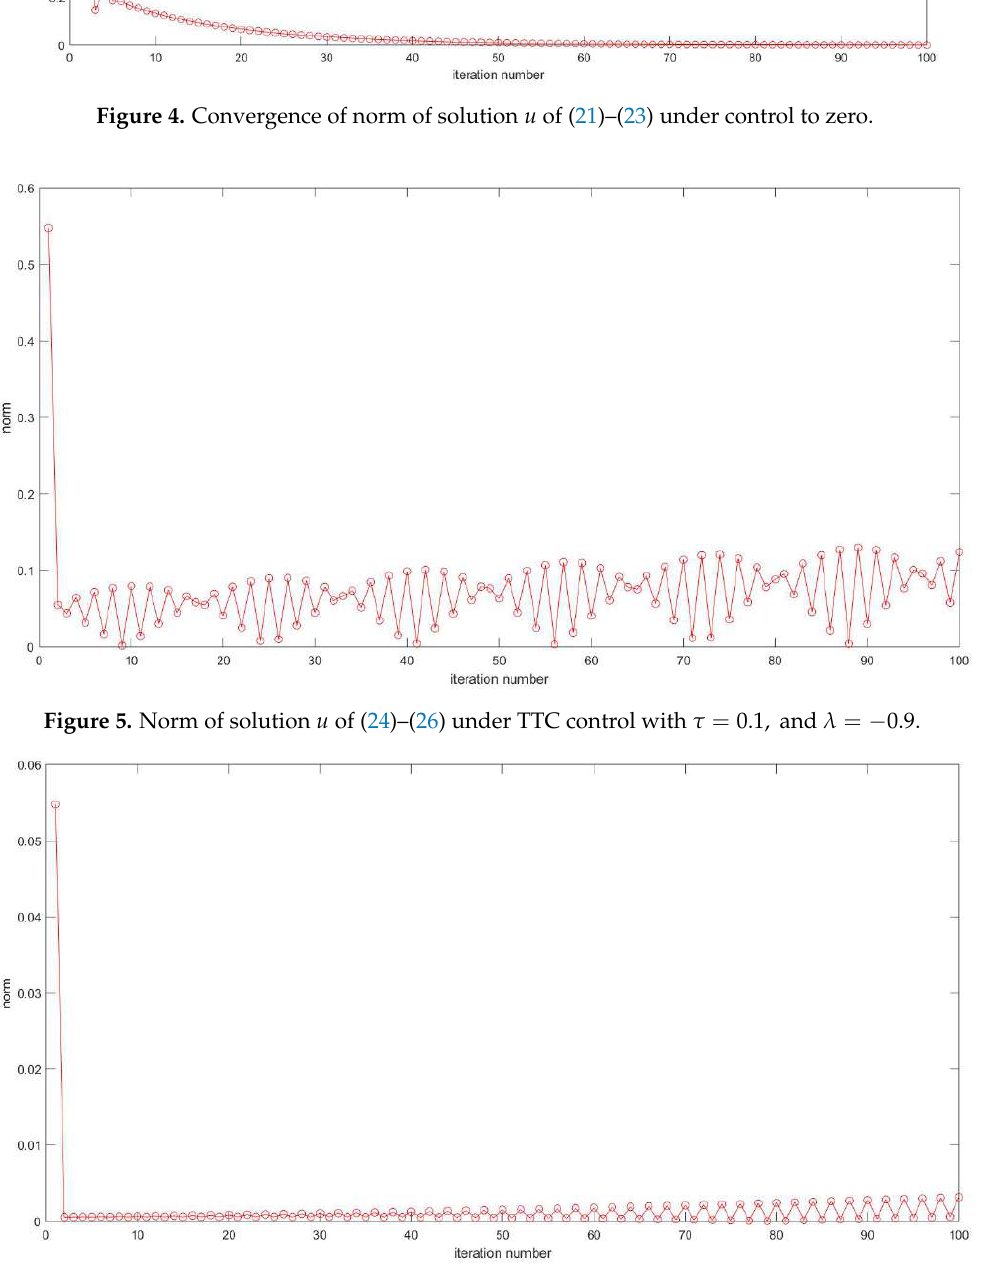
Figure 6. Norm of solution u of (24)–(26) under TTC control with τ = 0.01, and λ = −